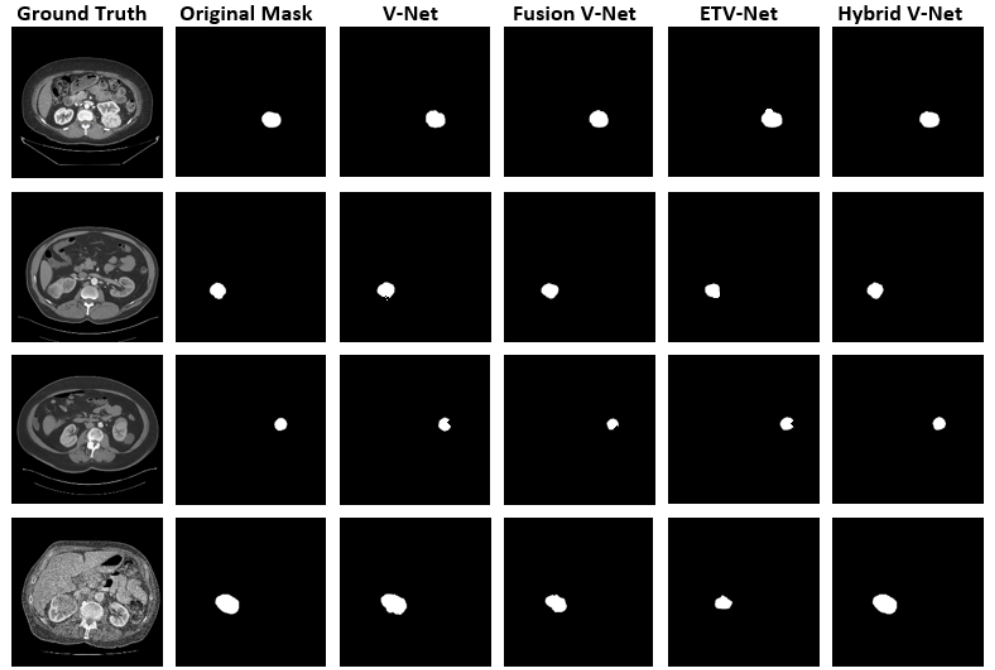
Figure 12. Original input CT images and kidney segmentation output images.